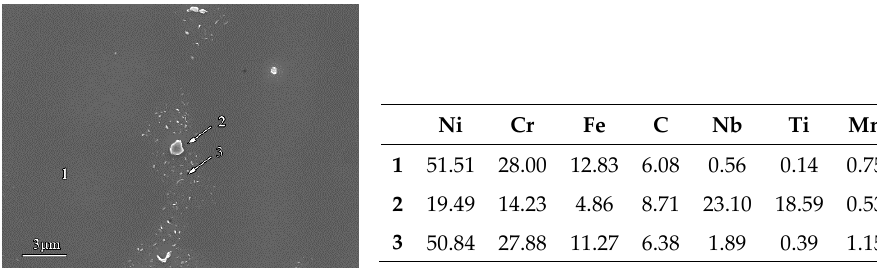
Figure 11. Compositions of precipitates in the GTAW+EMS welds of Alloy 52M. In the cap region of Alloy 52MSS welds, the dendrites were irregular. There were many precipitates, around 1~3 μ m in size, distributed between the cellular dendrites. In the middle region, there were a large number of coarse island-like precipitates, about 6 μ m in size, in the inter-dendritic areas. They were the largest of all. In the root region, the precipitates were coarse-grained, as revealed in Figure 12. In Alloy 52MSS weld, the large phases are (Ni,Cr,Fe)2(Nb,Mo,Si) according to the compositional analysis. These large phases are thought to be Laves phases [25]. There are also some tiny (Nb,Mo,Ti)Cs, as shown in Figure 13.